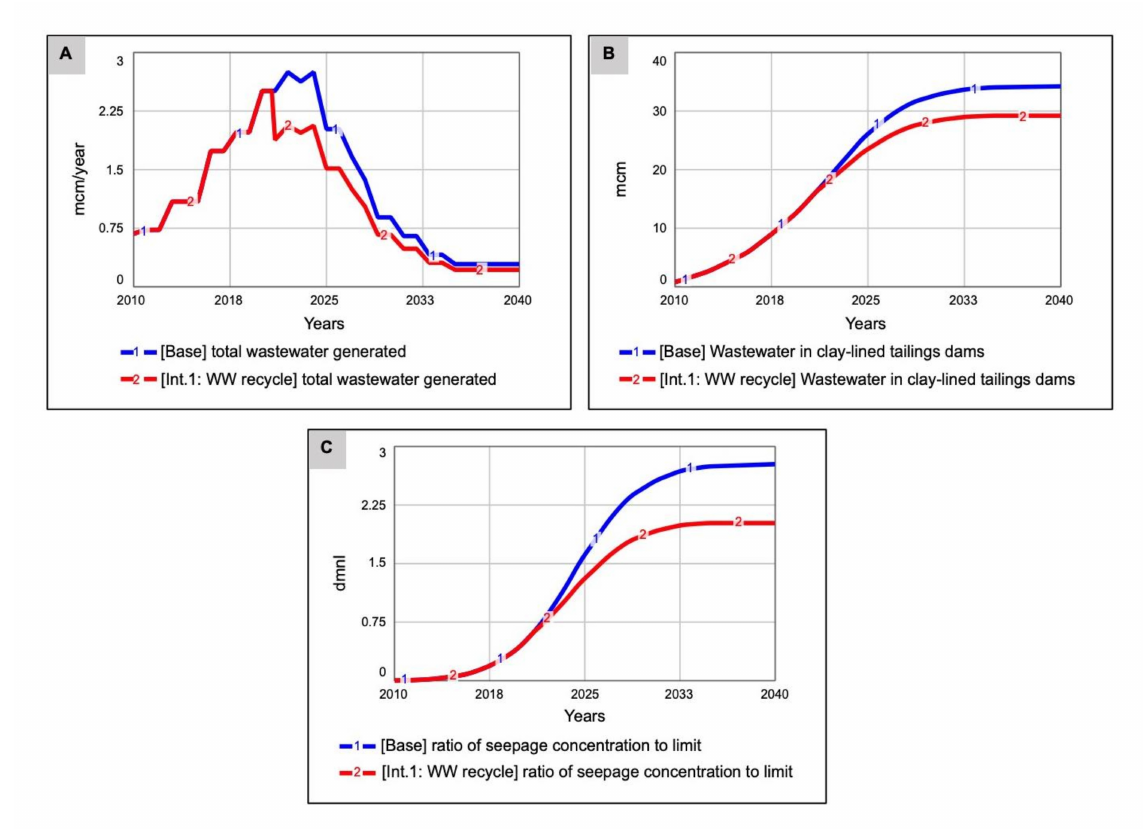
Figure 7. Comparative runs of the baseline simulation (Base) against Intervention 1 wastewater recycling (Int.1: WW recycle). ( A ): total wastewater generated; ( B ) wastewater in clay-lined tailings dams; and ( C ) ratio of seepage concentration to limit (the ratio is dimensionless hence dmnl). Note that the x -axis is shortened to only display the results from 2010–2040 in order to enhance the legibility of the